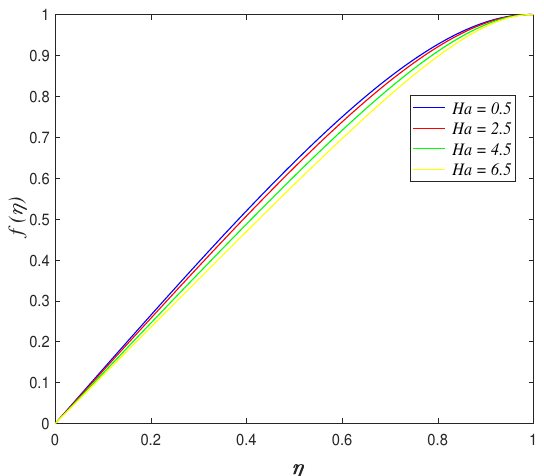
Figure 10. Impact of Ha on radial